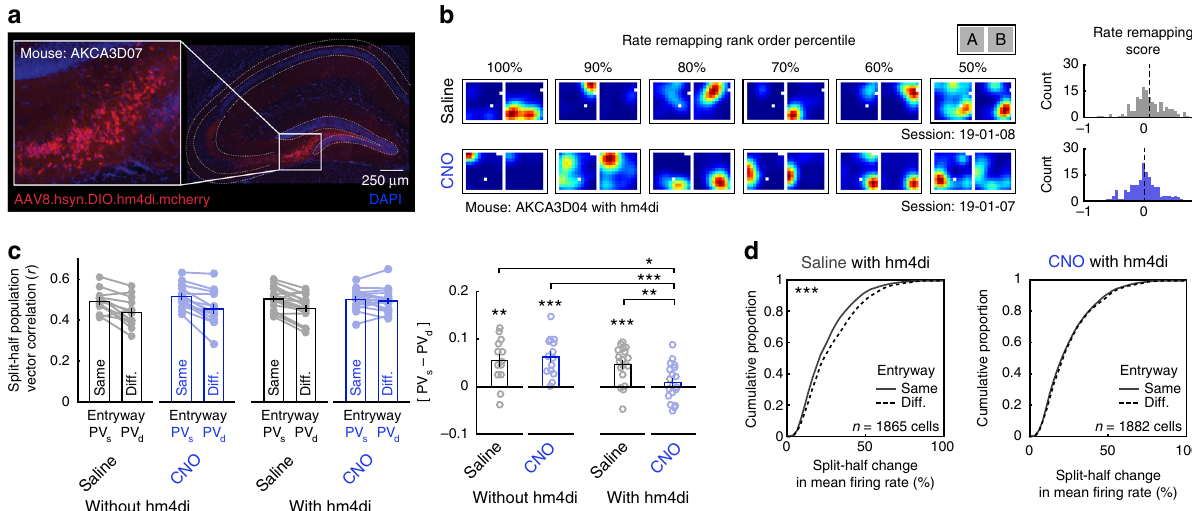
Fig. 4 Inhibition of DG – CA3 circuitry eliminates remapping of the CA1 rate code. a Representative example of cre-mediated hm4di-mcherry transfection in left dorsal DG and CA3 (see Supplementary Fig. 18 for additional examples and quanti fi cation details). b Six example rate maps of simultaneously recorded place cells from consecutive Saline/CNO sessions selected and ordered by their rate remapping score rank (left). Rate maps are normalized from zero (blue) to the peak (red) across both maps. Distribution of rate remapping scores and mean score for these example sessions (right). Rate remapping score de fi ned as split-half change in mean fi ring rate for different minus same entryway. c Split-half correlations of population activity within the compartment when the mouse entered from the same versus the different entryway for all conditions. Correlations were signi fi cantly higher when the mouse entered from the same entryway in all conditions except for CNO with hm4di (Wilcoxon signed-rank test: without hm4di Saline: p = 0.0046; without hm4di CNO: p = 1.2e − 4; with hm4di Saline: Z = 3.380; p = 7.2e − 4; with hm4di CNO: Z = 0.9256, p = 0.355). Correlation differences were signi fi cantly lower in the CNO with hm4di condition than all other conditions (Wilcoxon rank-sum tests: without hm4di Saline versus without hm4di CNO: Z = 0.267, p = 0.790; without hm4di Saline versus with hm4di Saline: Z = 0.691, p = 0.490; without hm4di CNO versus with hm4di Saline: Z = 1.147, p = 0.251; without hm4di Saline versus with hm4di CNO: Z = 2.379, p = 0.017; without hm4di CNO versus with hm4di CNO: Z = 3.479, p = 5.0e − 4; with hm4di Saline versus with hm4di CNO: Z = 2.861, p = 4.2e − 3). d Cumulative distribution of split-half changes of mean fi ring rates within the compartment when the mouse entered from the same versus the different entryway for mice with hm4di. Mean fi ring rates were signi fi cantly more similar when the mouse entered from the same entryway during Saline sessions (Wilcoxon signed-rank test: Z = 5.052, p = 4.4e − 7), but not during CNO sessions ( Z = 1.024, p = 0.306). All bar graphs re fl ect mean ± 1 SEM; p -values are uncorrected and two-sided. Data from ( c , d ) provided as Source data fi le. * p < 0.05, ** p < 0.01, *** p <